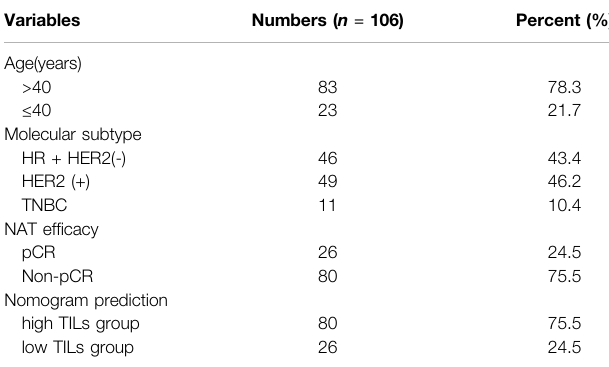
TABLE 5 | general infromation in independent validation